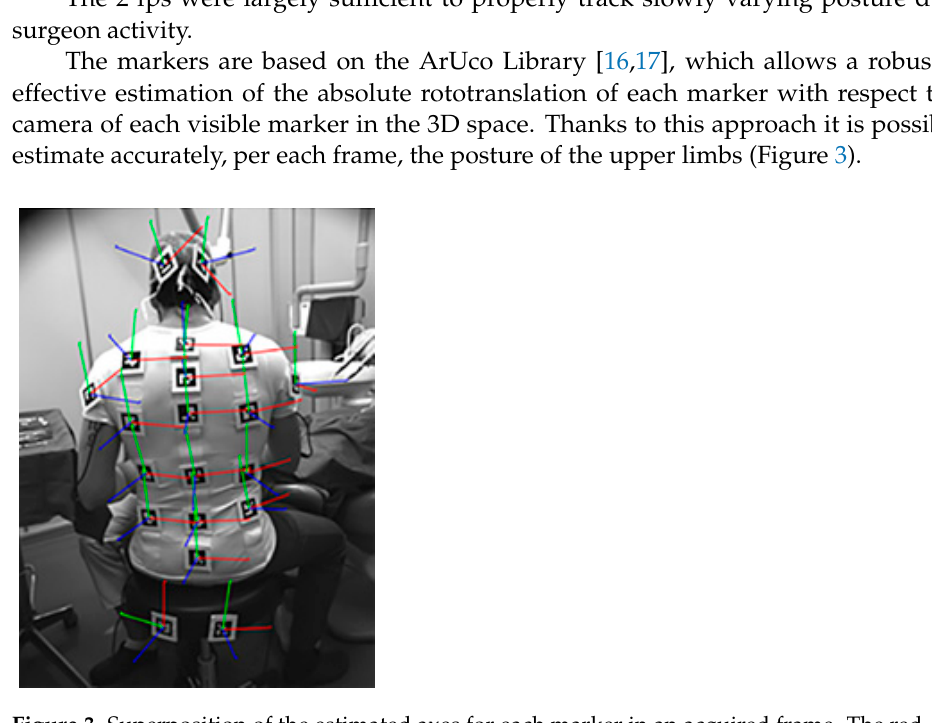
Figure 3. Superposition of the estimated axes for each marker in an acquired frame. The red, green, and blue vectors represent the x, y, and z axis, respectively.